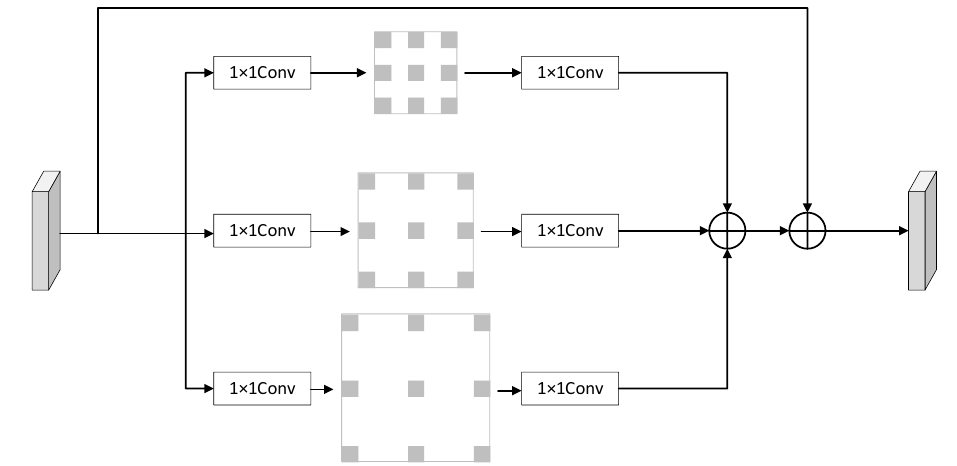
Figure 7. Multi-branch dilated convolution module (MDCM).